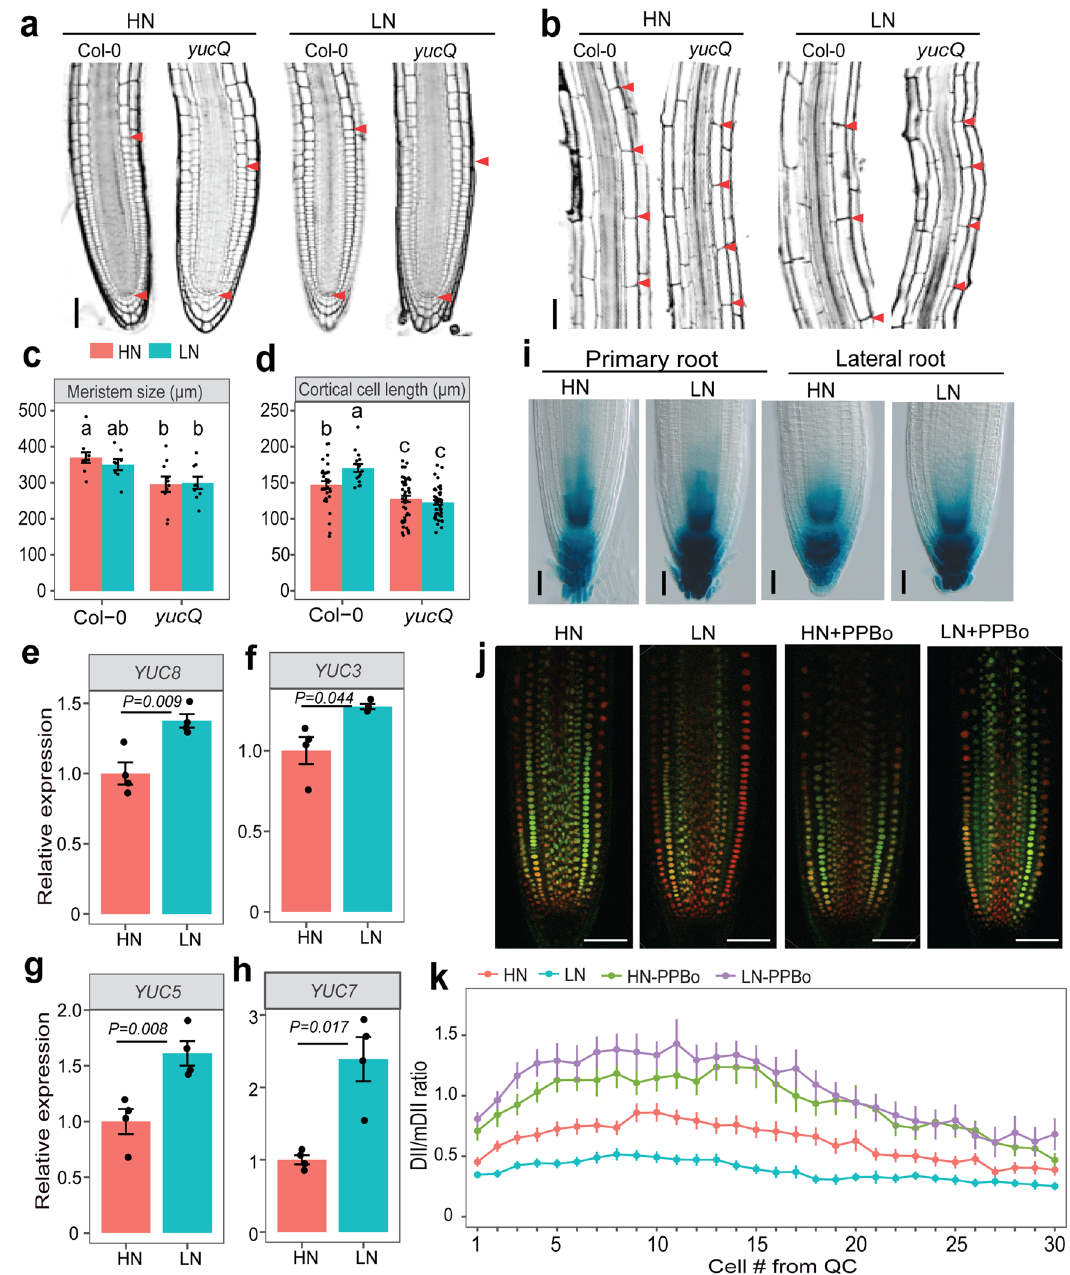
Fig. 2 YUCCA-dependent auxin biosynthesis is required to stimulate LR elongation under low N. a – b Representative confocal images of root meristems ( a ) and mature cells ( b ) of Col-0 and yucQ LRs grown under high N (HN, 11.4 mM N) or low N (LN, 0.55 mM N). Red arrowheads indicate the position of the quiescent center (QC) and the boundaries between the meristematic and elongation zones ( a ) or between two consecutive mature cortical cells ( b ). Scale bars, 50 μ m. c – d Length of the meristem ( c ) and cortical cells ( d ) of LRs from Col-0 and yucQ plants grown under HN or LN. Bars represent means ± SEM. Number of individual roots or cells analyzed in HN/LN: n = 10/8 (Col-0) and 10/9 ( yucQ ) in ( c ); 34/16 (Col-0) and 45/43 ( yucQ) in ( d ). Different letters indicate signi fi cant differences at P < 0.05 according to one-way ANOVA and post hoc Tukey test. e – h Transcript levels of YUC8 ( e ), YUC3 ( f ), YUC5 ( g ), and YUC7 ( h ) in response to HN and LN. Root samples for q PCR analysis were taken 9 days after transfer. Expression levels were assessed in whole roots by q PCR analysis and normalized to ACT2 and UBQ10 . Bars represent means± SEM ( n = 4 independent biological replicates). P values relate to differences between two N conditions according to Welch ’ s t -test. i proYUC8 -dependent GUS activity in the tips of primary root (left panel) and LR (right panel) at 9 days after transfer to HN or LN. Scale bars, 100 µ m. j Representative images of mDII-ntdTomato and DII-n3xVenus in tips of mature LRs grown HN or LN and supplemented with 5 µ M YUCCA activity inhibitor 4-phenoxyphenyl boronic acid (PPBo). k DII-n3xVenus/mDII-ntdTomato intensity ratio in epidermal cells of mature LRs. The experiments in ( a , b ) and ( i , j ) were repeated twice with similar results. Dots represent means ± SEM ( n = 30, 25, 15, and 15 roots for HN, LN, HN-PPBo and LN-PPBo, respectively). Scale bars, 100 µ m.